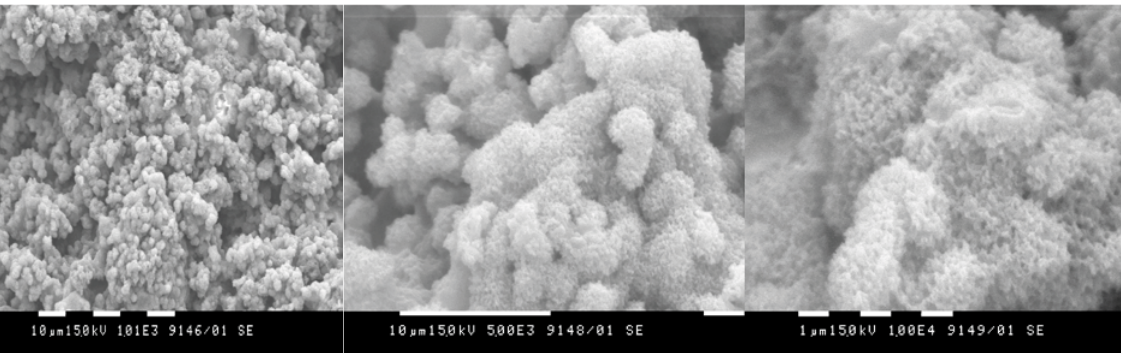
Figure 8. SEM micrographs of 75G:25CPS/W (wt.%) after in vitro test in 1.5 SBF for 3 days at different magnification values.